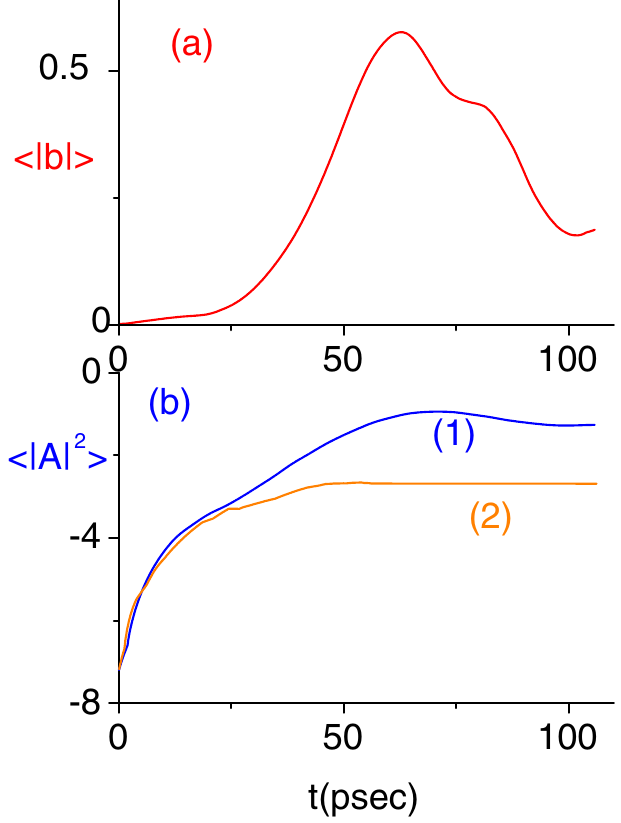
FIG. 1. (Color) (a) average bunching hj b ji in the middle of the bunch vs time, (b) logarithmic plot of hj A j 2 i vs time in picoseconds in the (1) coherent and (2) incoherent case. In (cid:4) 50 (cid:11) m with a flat laser profile, (cid:2) a the calculation w 0 0 : 3 , Q (cid:4) 3 nC , I (cid:4) 0 : 9 kA , h (cid:6) i (cid:4) 60 , (cid:4) p 0 : 6 (cid:11) m , (cid:4) !=! (cid:4) (cid:1) 10 (cid:1) 4